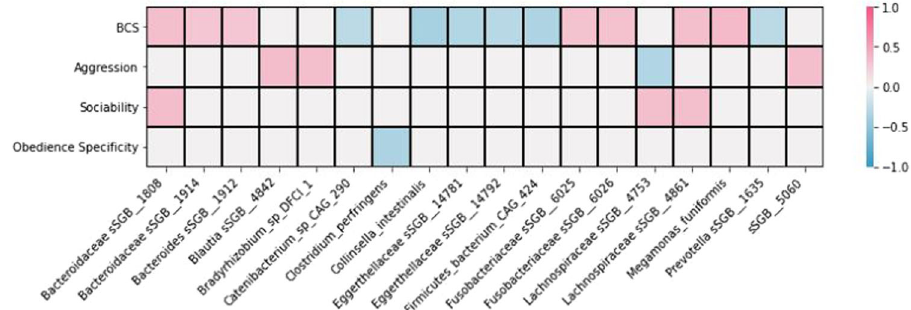
Fig. 8 Heatmap depicting correlation among bacterial families and canine demographic and phenotypic data. Only values signi fi cant after false discovery rate (FDR) correction (level = 0.05) are presented in this fi gure. *BCS Body Condition Score.